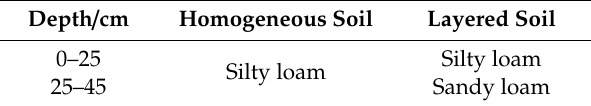
Table 3. Experimental soil